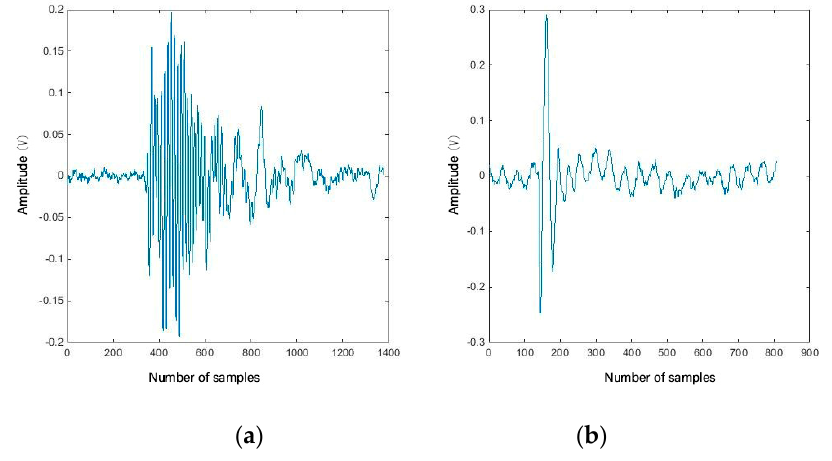
Figure 9. Examples of the two types of signals recorded during the tracing phase: Signals generated by damaged wood ( a ), parasitic electronic and magnetic feedback signals ( b ).